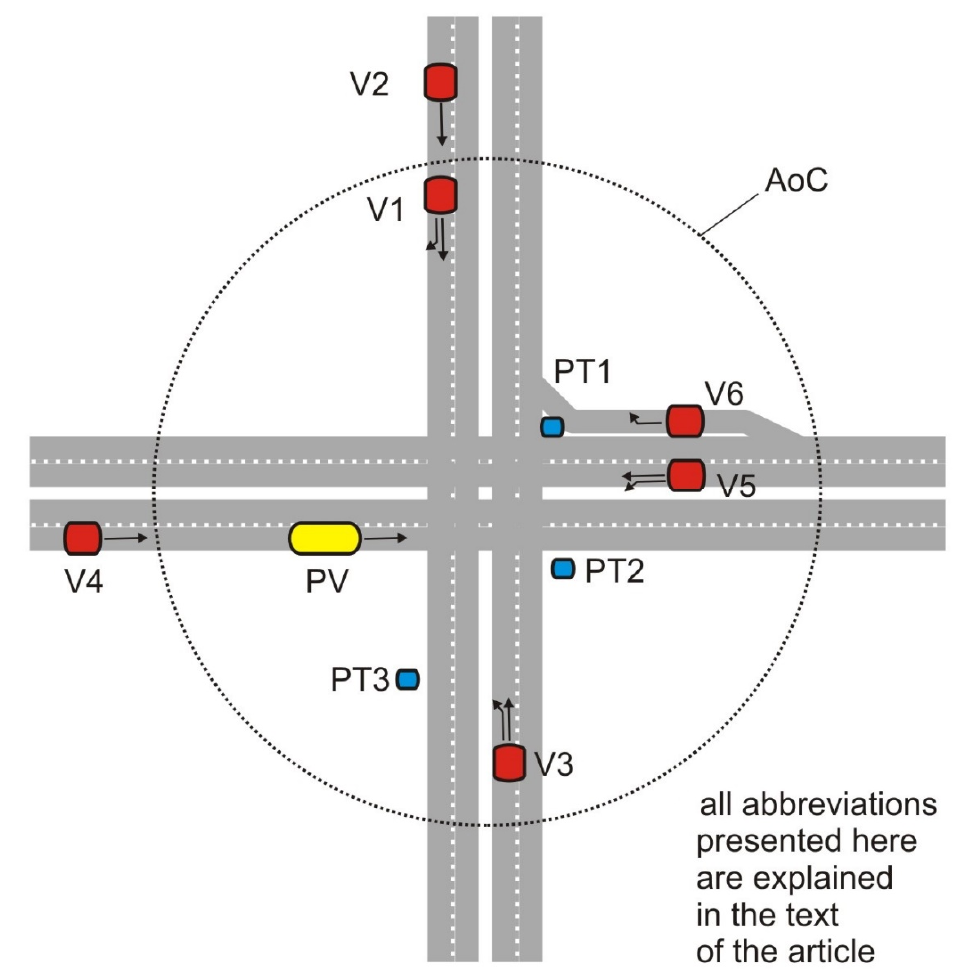
Figure 3. The model for case 2: Communication of vehicles with traffic signals and other users.